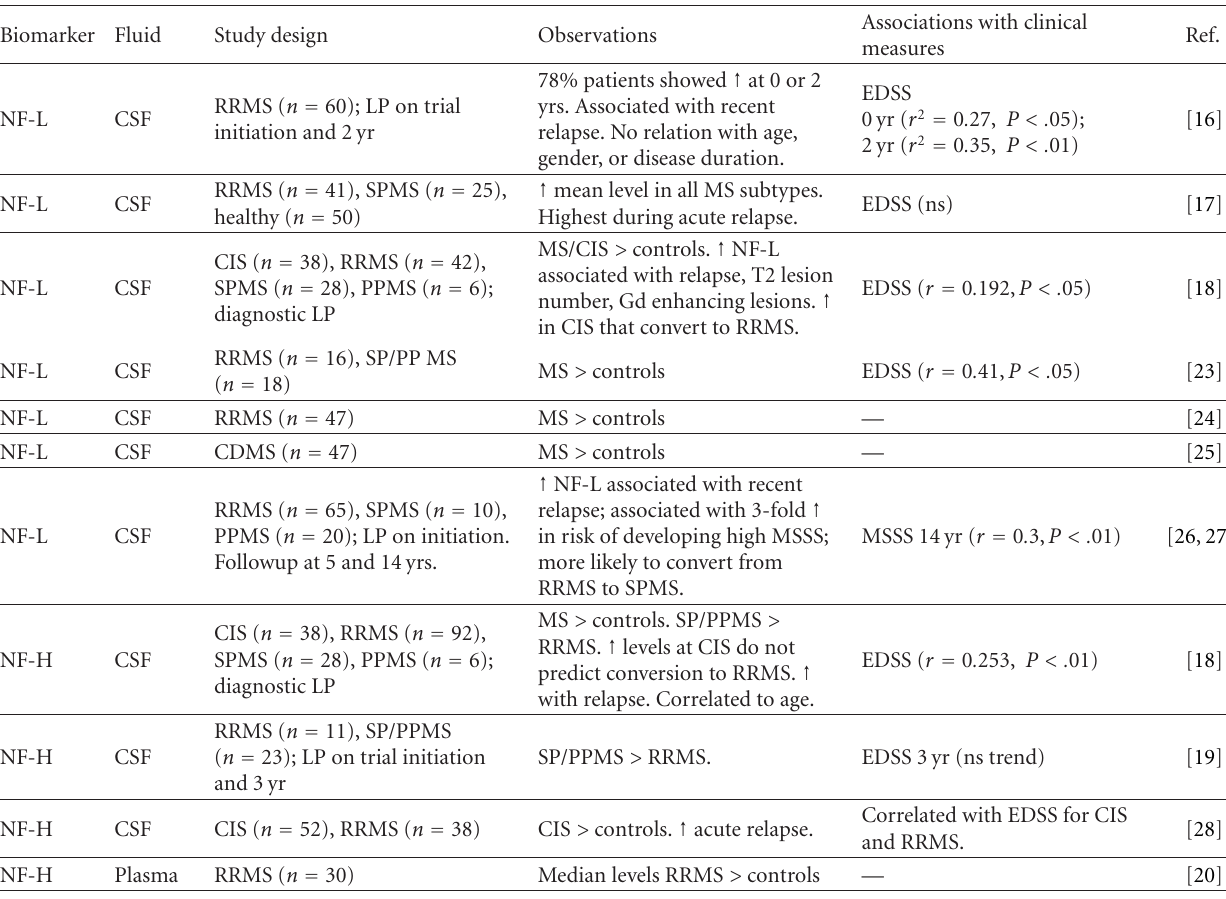
Table 1: Summary of studies assessing the utility of neurofilaments as biomarkers of axonal damage in patients with multiple sclerosis (MS) and clinically isolated syndrome